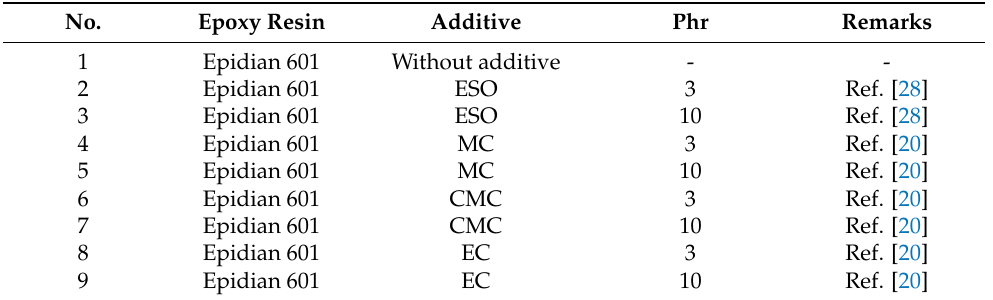
Table 1. Composition of epoxy/additive mixtures for determining mechanical properties.